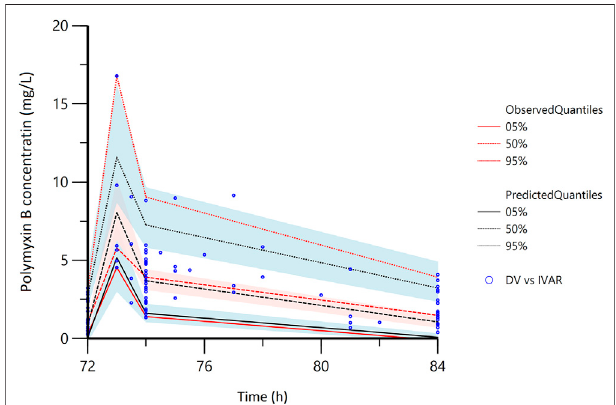
FIGURE 3 | The partial prediction corrected-visual predictive check of the fi nal model. The red lines represent the 5th, 50th, and 95th percentiles of the observed concentrations; the shaded areas represent the 90% con fi dence intervals of the 5th, 50th, and 95th percentiles of the simulated concentrations, respectively; the dots represent the observed data; DV, observed concentration; IVAR, Time.